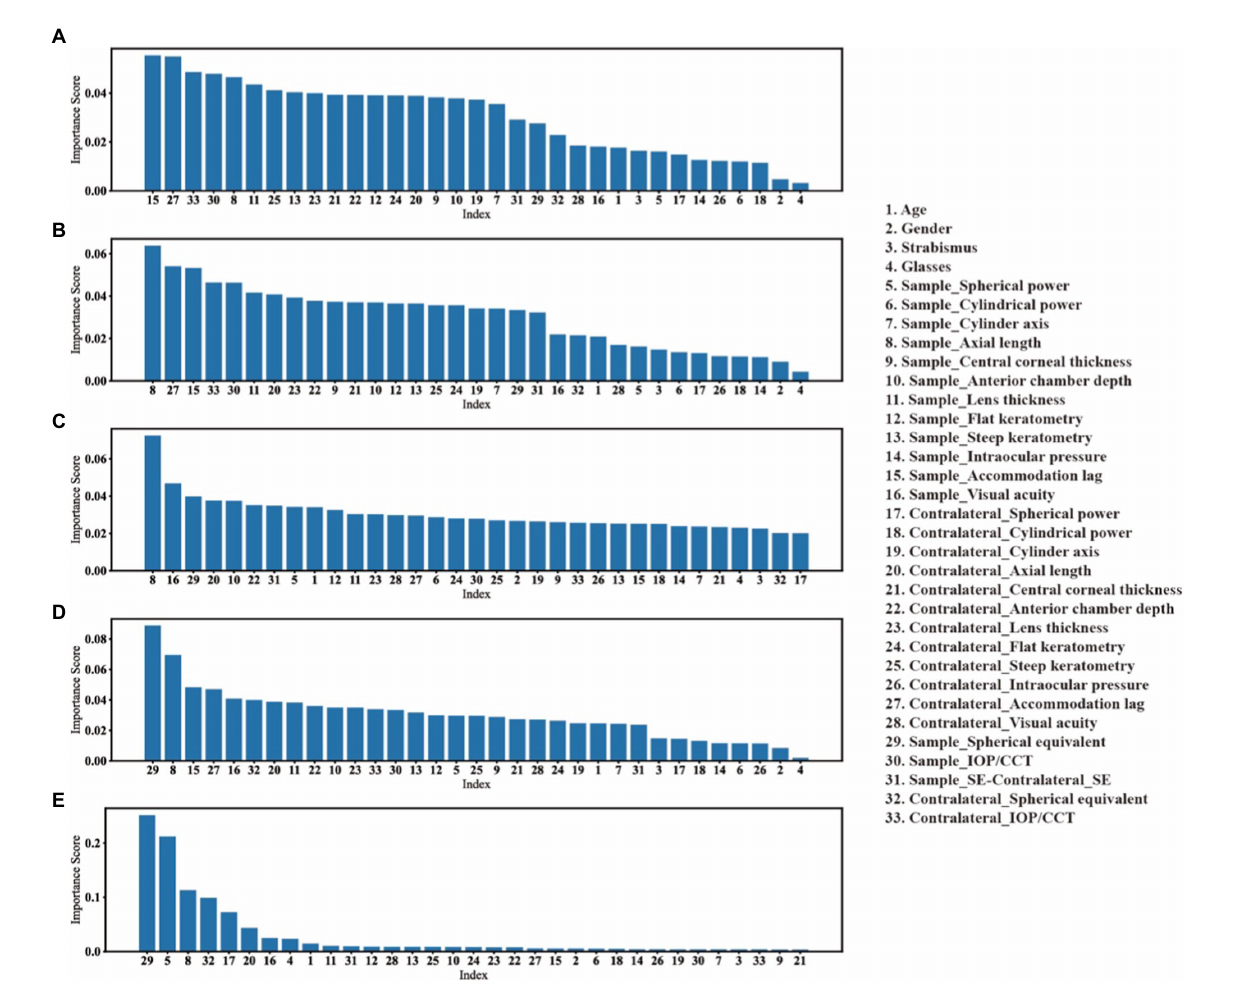
FIGURE 5 The features’ importance in each prediction task. We take the reduction in impurity as the importance of that feature. (A–C) , the features importance of EEC model in predicting the need for cycloplegia with threshold is 0.25D, 0.5D and 0.75D, respectively. (D) , the features importance of EEC model in predicting the cycloplegic refractive states. (E) , the features importance of ABR model in predicting the values of cycloplegic